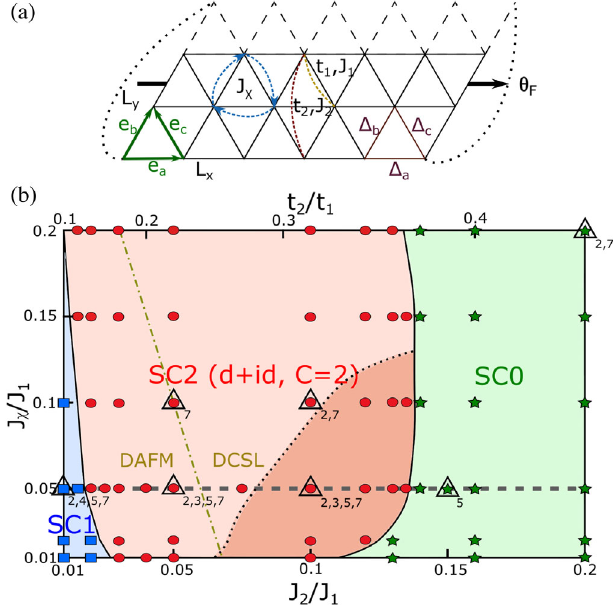
FIG. 1. Quantum phase diagram. (a) Schematic illustration of the extended t - J - J χ model on triangle lattice with the nearest- neighbor and the next-nearest-neighbor hoppings t 1 and t 2 and Heisenberg exchange J 1 and J 2 interactions, as well as the three- spin chiral interactions J χ . The dashed lines indicate the periodic boundary condition. (b) The quantum phase diagram obtained on 6 cylinders based on the Chern number simulations. For L y ¼ =J J =J ≤ 0 . 2 , and doping level δ ¼ 1 = 12 , we 0 . 01 ≤ J 2 1 , χ 1 identify distinct classes of SC phases labeled as SC1, SC2, and SC0 from left to right characterized by their spin Chern number C . The SC2 regime represents two phases: the isotropic TSC (lighter red region) and nematic TSC (darker red region) phases. Different symbols represent parameter points studied with the DMRG methods. The triangles mark points presented in the paper with the lower indices representing the indices of figures. A scan of the Chern number, SC pairing symmetry, and energy or entropy along the horizontal dashed line is used in Figs. 2(c), 5(d), and 6, respectively. The main feature of the phase diagram is essentially the same for other doping levels δ ¼ 1 = 24 – 1 = 8